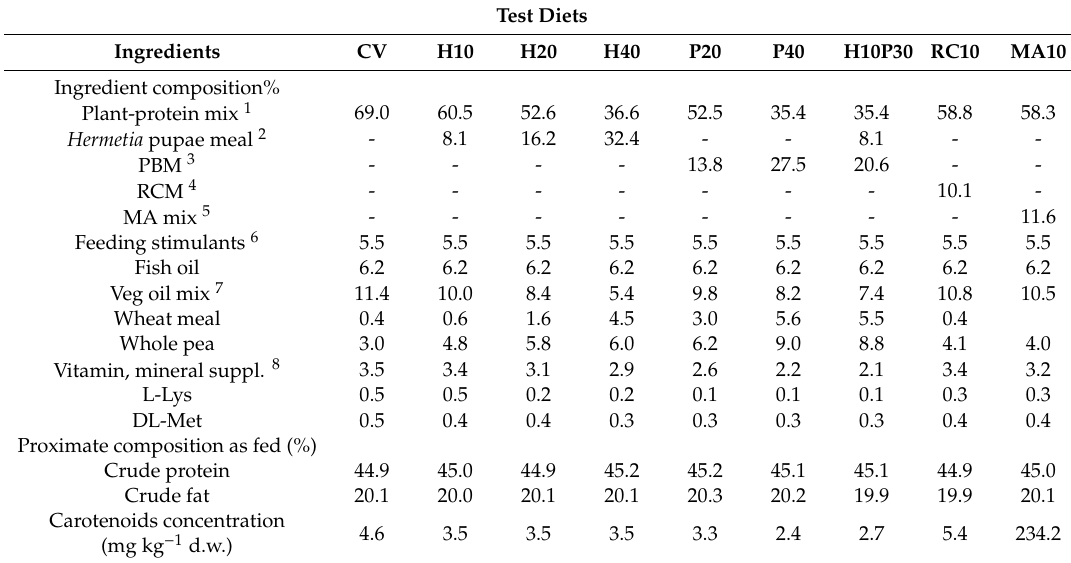
Table 2. Ingredient composition, crude protein, lipid levels and total carotenoids content of the test diets. CV: vegetable control; H: Hermetia illucens; P: poultry by-product; RC: red swamp crayfish; MA: microalgae dried biomass.